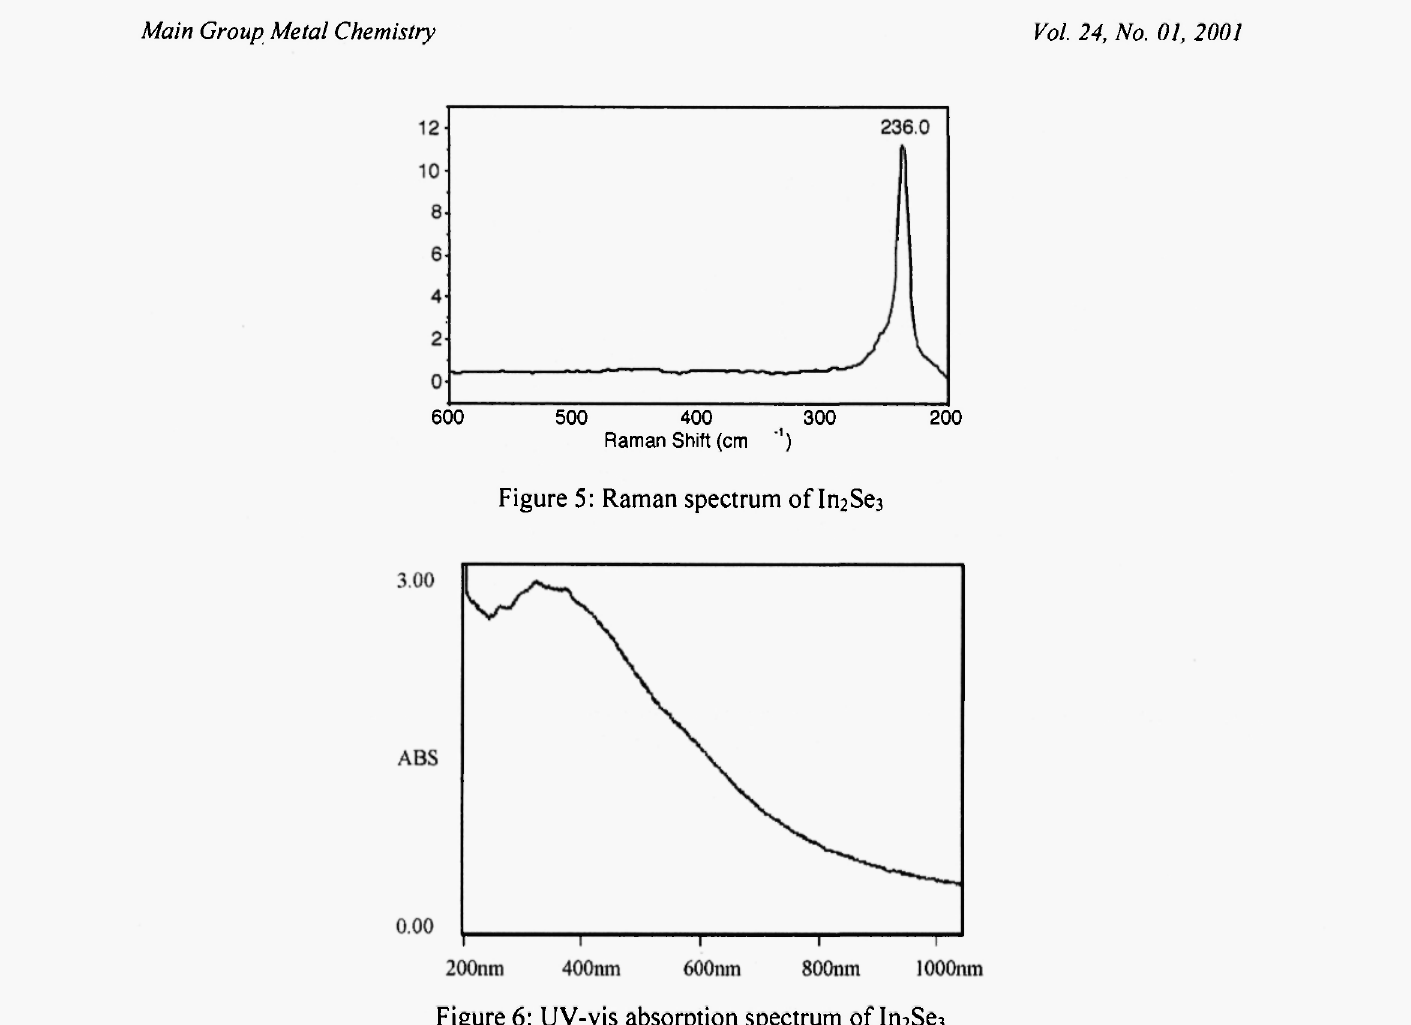
Figure 6: UV-vis absorption spectrum of